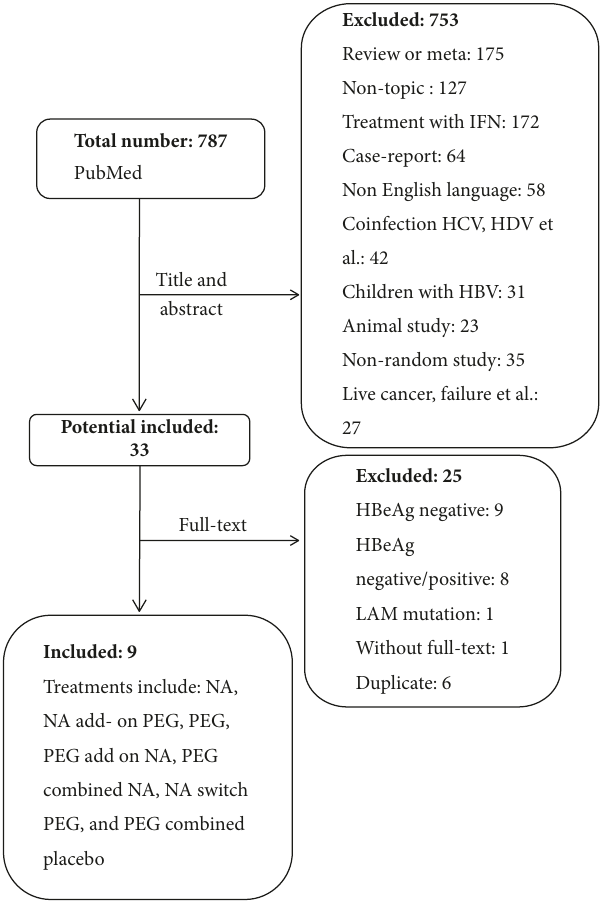
Figure 1: Flow chart of study selection and